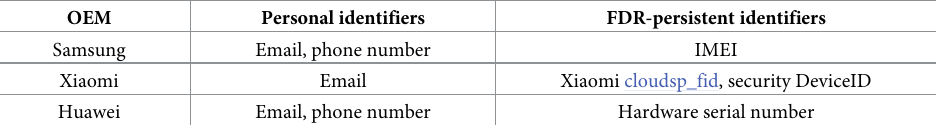
Table 2. FDR-persistent identifiers linked to personal identifiers during sign-in to OEM account on handset. There was no OEM account login option on the Realme handset studied.